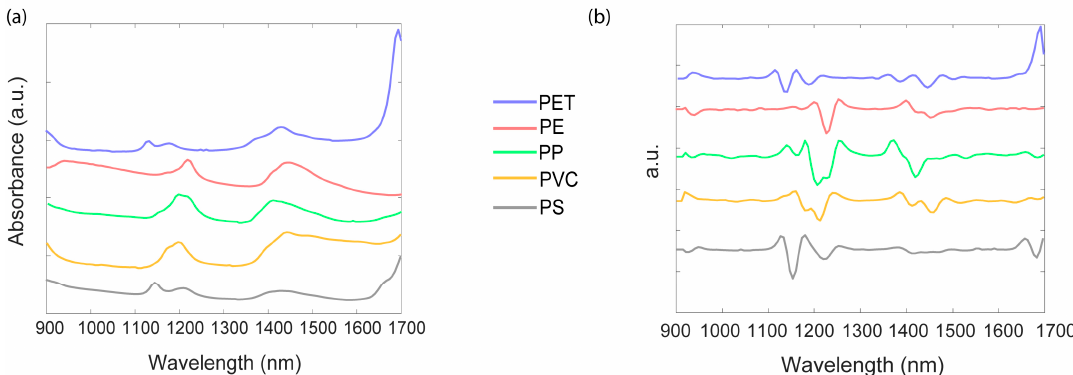
Figure 2. Near-infrared (NIR) spectra of five classes of plastics: ( a ) representative raw spectra of the five classes; ( b ) corresponding spectra after pre-treatment by second derivative and standard normal variate (SNV). PE: polyethylene; PET: poly(ethylene terephthalate); PP: polypropylene; PS: poly(styrene); PVC: poly(vinyl chloride).